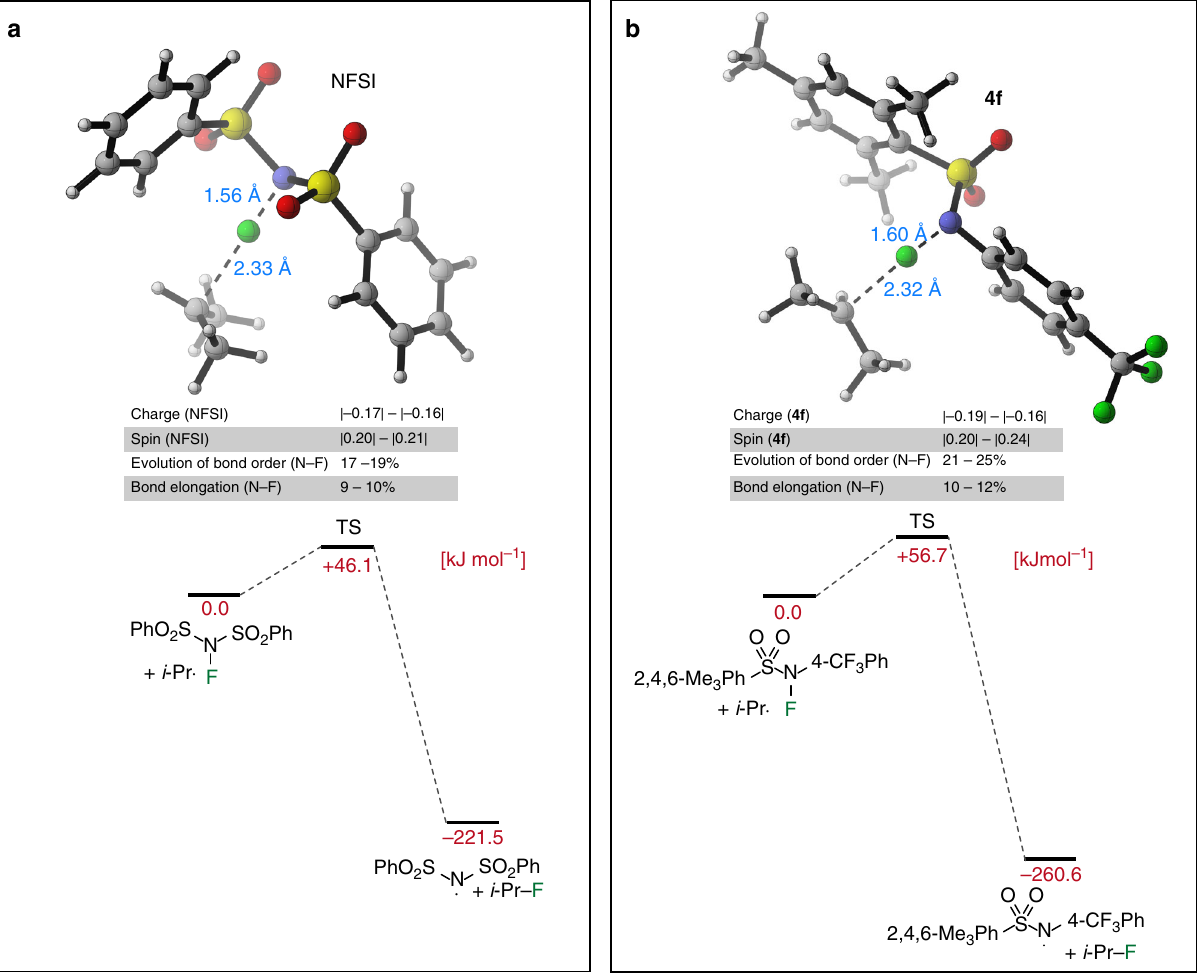
Fig. 8 Calculated transition states for the fl uorination of the isopropyl radical. a Free energy surfaces ( Δ G sol-opt , in kJ mol − 1 ) in DMF solution for the reaction of isopropyl radical ( i -Pr (cid:129) ) with NFSI and b 4f calculated at the (RO)B2PLYP/G3MP2Large level of theory. Distances (in Å), NPA charges and NPA spin distributions have been calculated at the SMD(DMF)/(U)B3LYP/6 – 31G(d) level of theory. Free energies in solution Δ G sol-opt have been obtained by adding Δ G solv [(U)B3LYP/6 – 31G(d)/SMD(DMF)] to Δ G 298 [(RO)B2PLYP/G3MP2Large//SMD(DMF)/(U)B3LYP/6 –